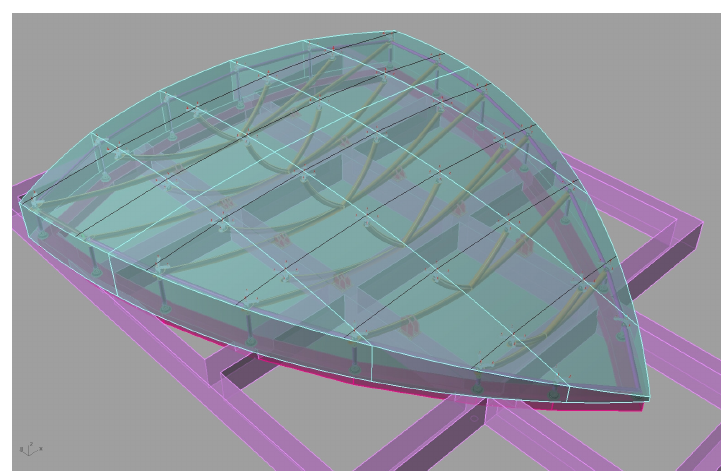
Figure 1: Sketch of the roof.